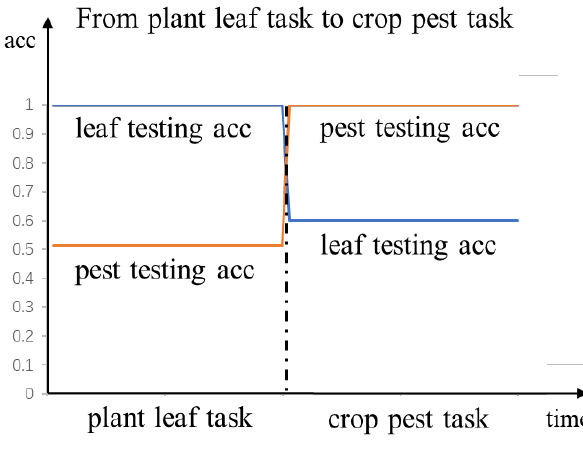
Figure 14. The testing accuracy of the second case.